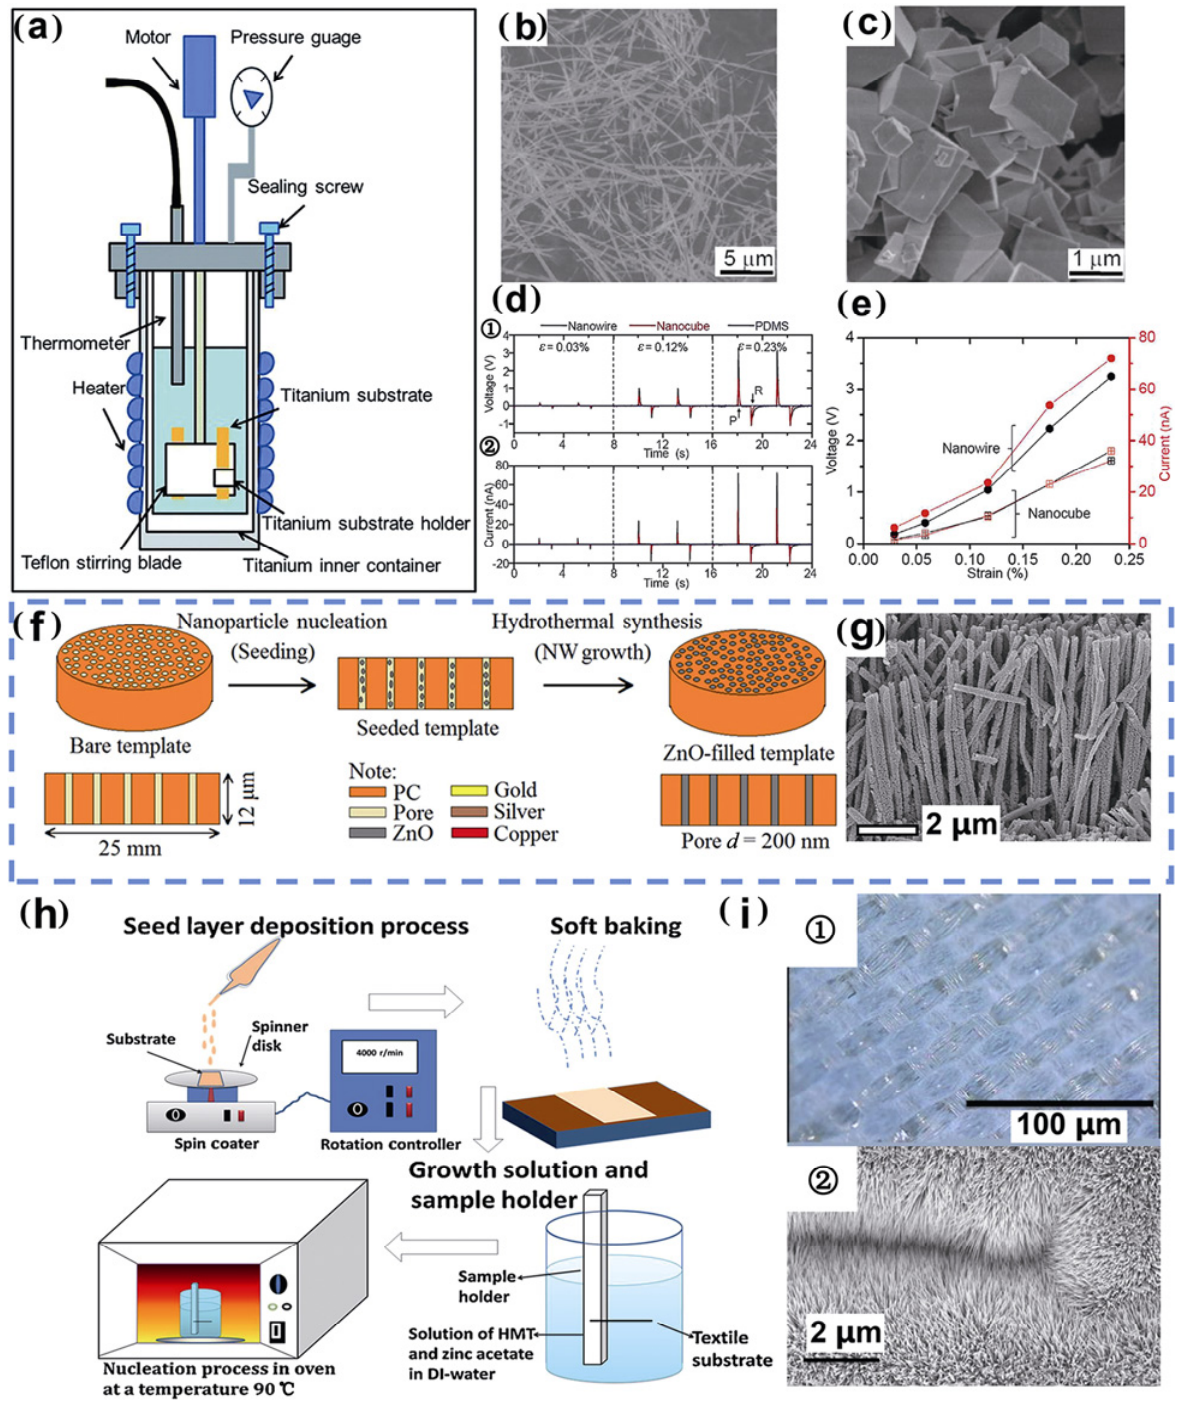
Fig. 4 (a) Schematic diagram of hydrothermal process. SEM images of (b) NaNbO 3 nanowire and (c) nanocube. (d) ① Open circuit voltage and ② closed circuit current of NaNbO 3 nanowire-based and nanocube-based nanogenerators at given compressive strain. (e) Comparison of generated power for NaNbO 3 nanowire-based and nanocube-based nanogenerators for various compressive strain values. (f) Fabrication process of template-assisted hydrothermal growth of aligned ZnO nanowires. (g) SEM micrograph of well-aligned ZnO nanowires. (h) Schematic illustration of growth procedure for ZnO nanoneedles. (i) ① Micrographic image of ArgenMesh Conductive textile and ② SEM image of grown ZnO nanoneedles (scale bar = 2 μ m). Reproduced with permission from Ref. [30] for (a), © The Royal Society of Chemistry 2019; Ref. [64] for (b–e), © American Chemical Society 2011; Ref. [114] for (f, g), © American Chemical Society 2016; Ref. [116] for (h, i), © Elsevier B.V.